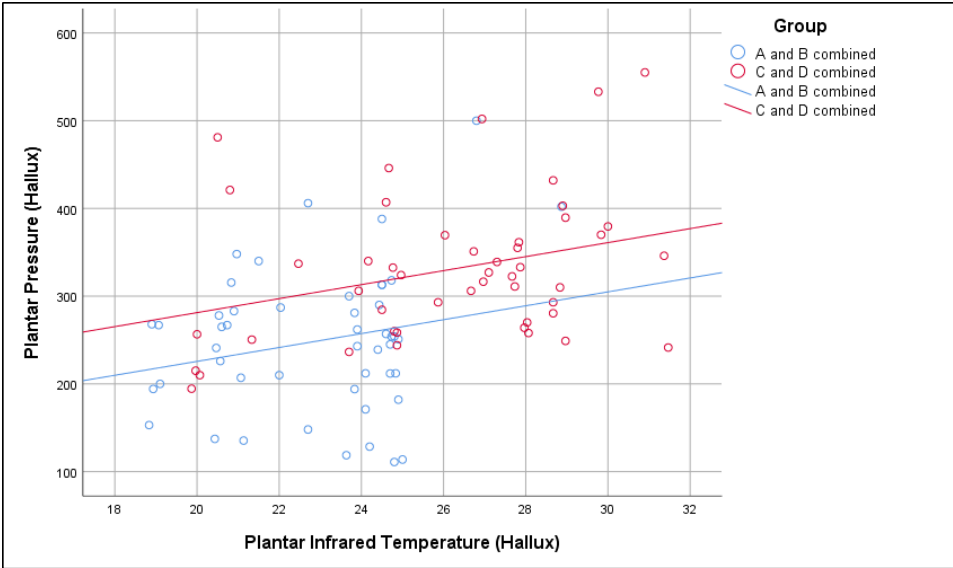
Figure 5. Correlation of plantar infrared temperature and plantar pressure at the hallux.